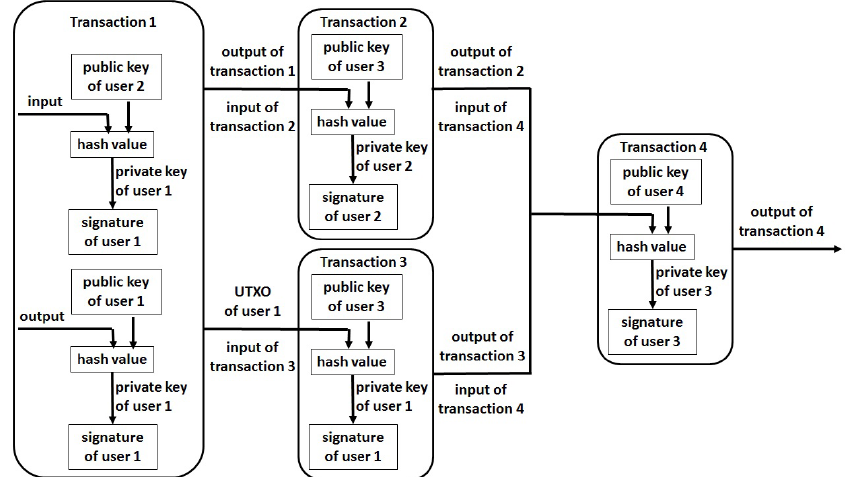
Figure 1. Trading